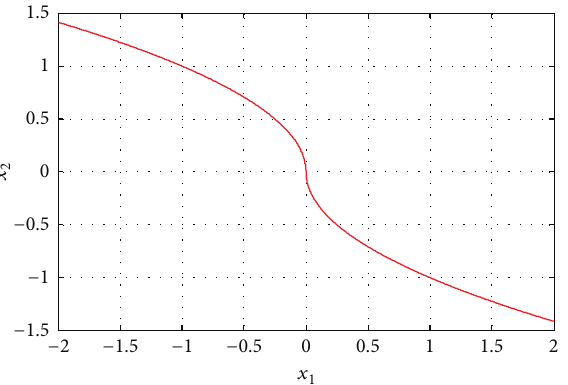
Figure 1: Example of a nonsingular terminal sliding